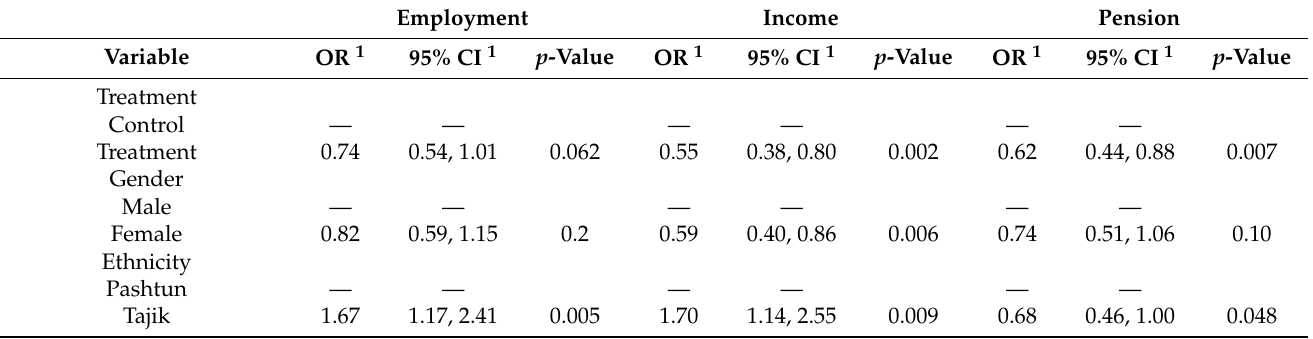
Table 5. Results of logistic models on employment, income, and pension